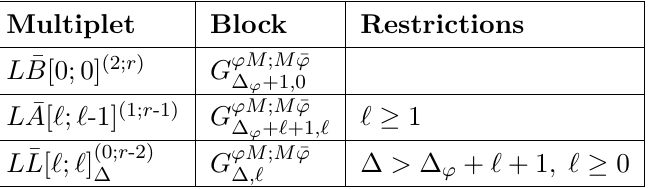
Table 6 . List of multiplets that appear in the ϕ r × M OPE. For each multiplet, the superconformal block can be found in equation